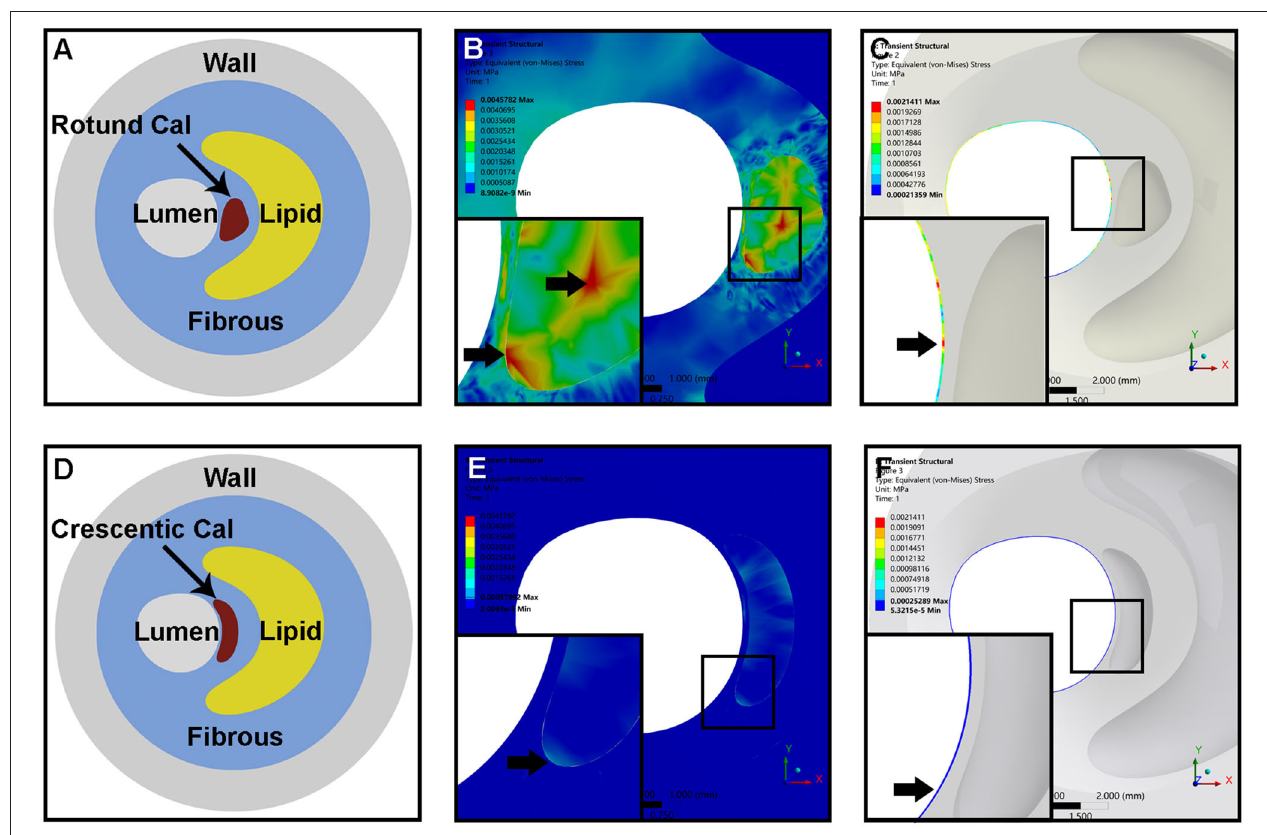
FIGURE 4 | The idealized models of an atheromatous plaque with rotund calcification (A) and crescentic calcification (D) . Representative of von Mises stress distribution within the whole plaque (B,E) and the fibrous on the lumen surface (C,F) of rotund calcification and crescentic calcification; the arrow indicated the location of maximum von Mises stress within the whole plaque and separated fibrous tissue.